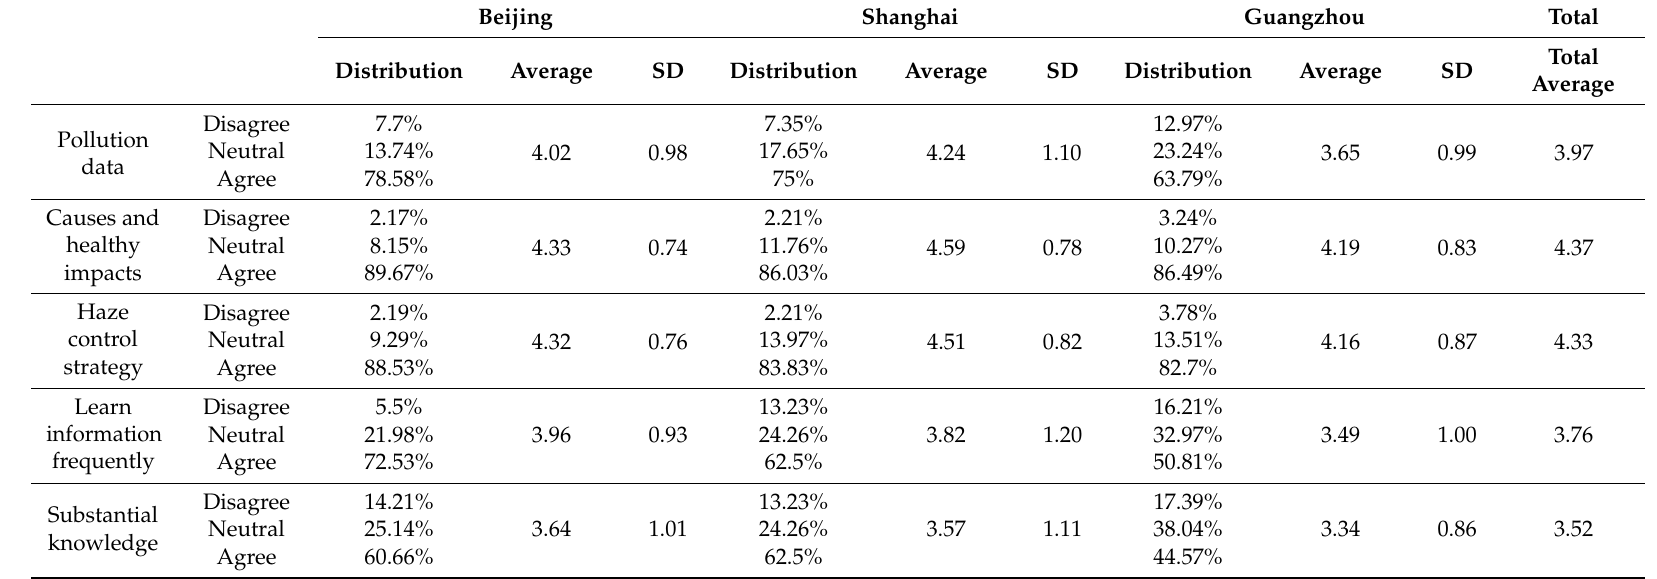
Table 11. Distribution of knowledge in Beijing, Shanghai, and